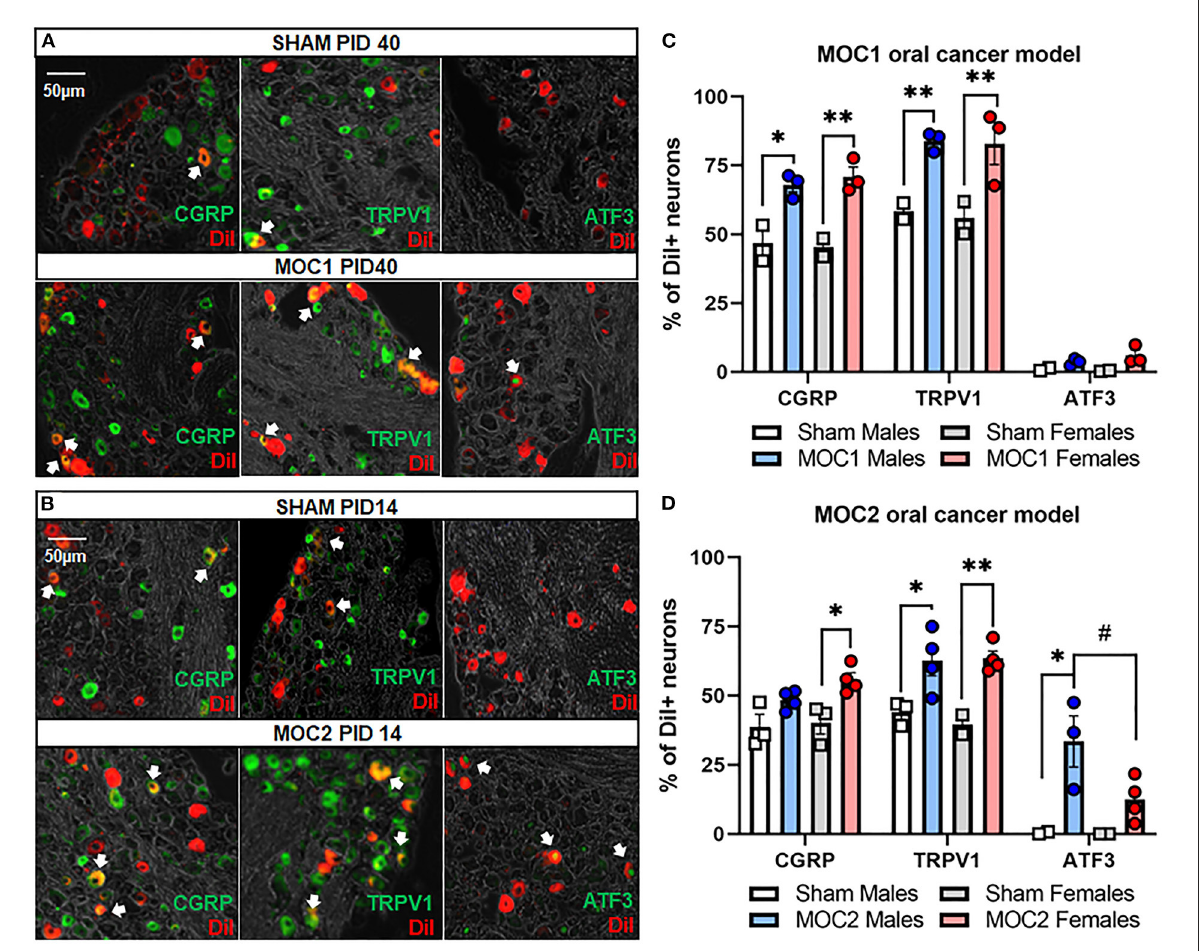
FIGURE4 Oral cancer-induced changes in pain-related protein expression. Each TG tissue sections from each retrogradely labeled mouse was stained with antibodies specific for either TRPV1, CGRP or ATF3. Representative immunostaining of all three markers in retrogradely labeled TG tissue from (A) sham and MOC1 mice at PID40 as well as (B) sham and MOC2 mice at PID14. (C,D) The percentage of DiI-labeled neurons expressing each marker was quantified from 2–4 animals per treatment group. Data are presented as mean + /- SEM of percentage of neurons expressing each marker. Two-way ANOVA, Treatment effect: * p < 0.05, ** p < 0.01, sex effect: # p <